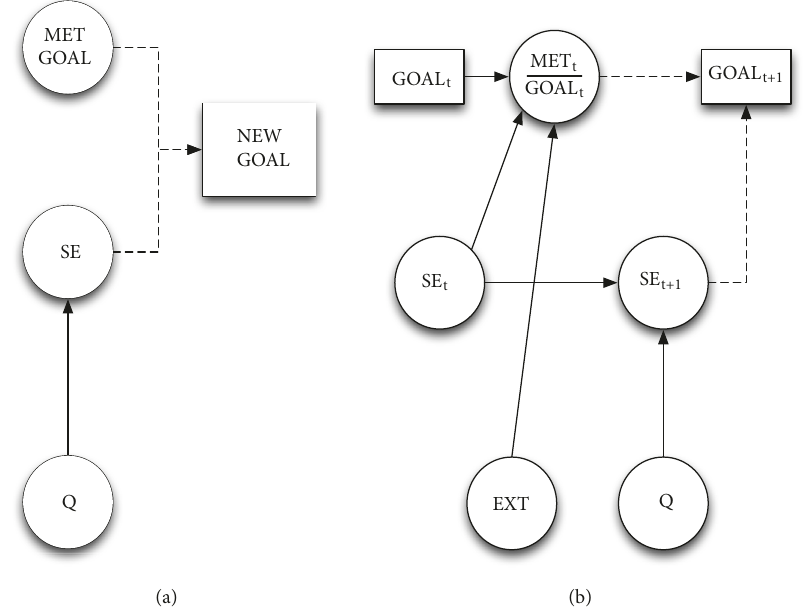
Figure 5: Part (a): the model basic decision step and Part (b): the relation between two consecutive “time slices” in the DDN model.